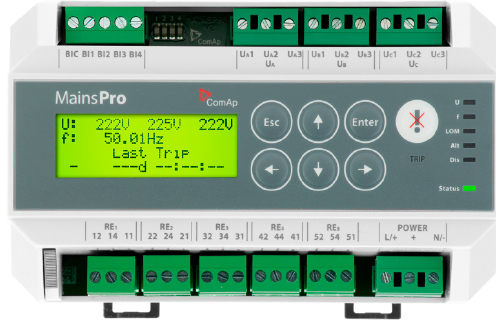
Figure 14. The MainsPro relay used in the HIL